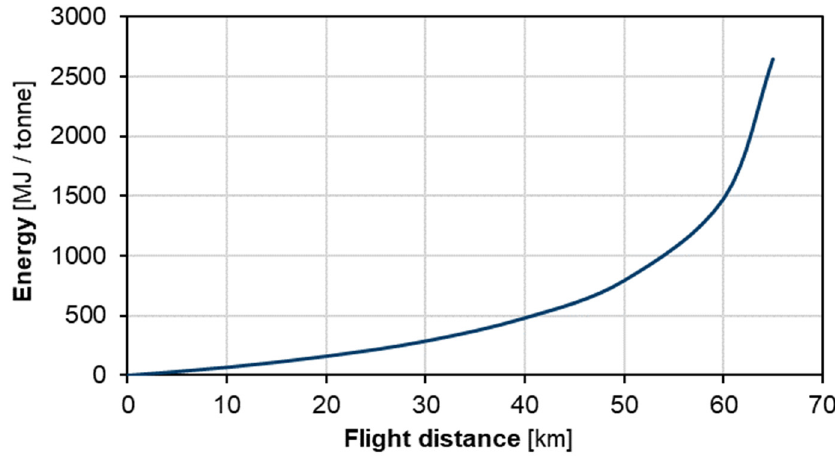
Figure 8. Freight unmanned aviation energy demand for Amazon Prime Air with a maximum capacity of 2.3 kg [27].